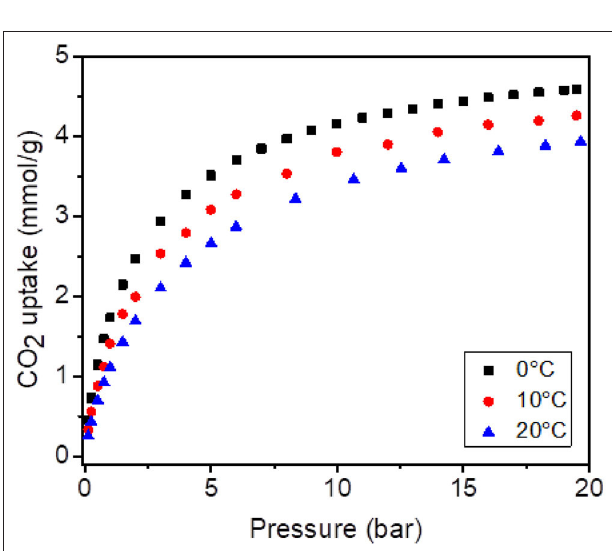
FIGURE 10 | CO 2 adsorption at 0, 10, and 20 ◦ C on the heterostructure, prepared by silylation of organo-modified graphene oxide with 1,4-Bis(triethoxysilyl)-benzene, and calcinated to give